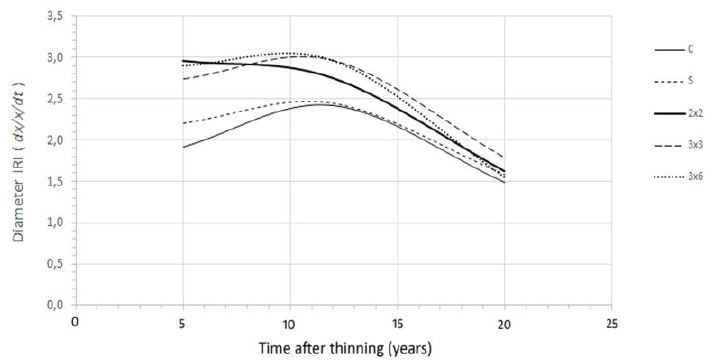
Figure 4. Increment rate index (IRI) for diameter. Relative variation in tree growth in diameter over time since the first measurement (5 years after thinning of 1995). Generally, there is an increasing growth response for 12 years after thinning. After this period, tree growth decreases progressively. The response also varies among the treatments.